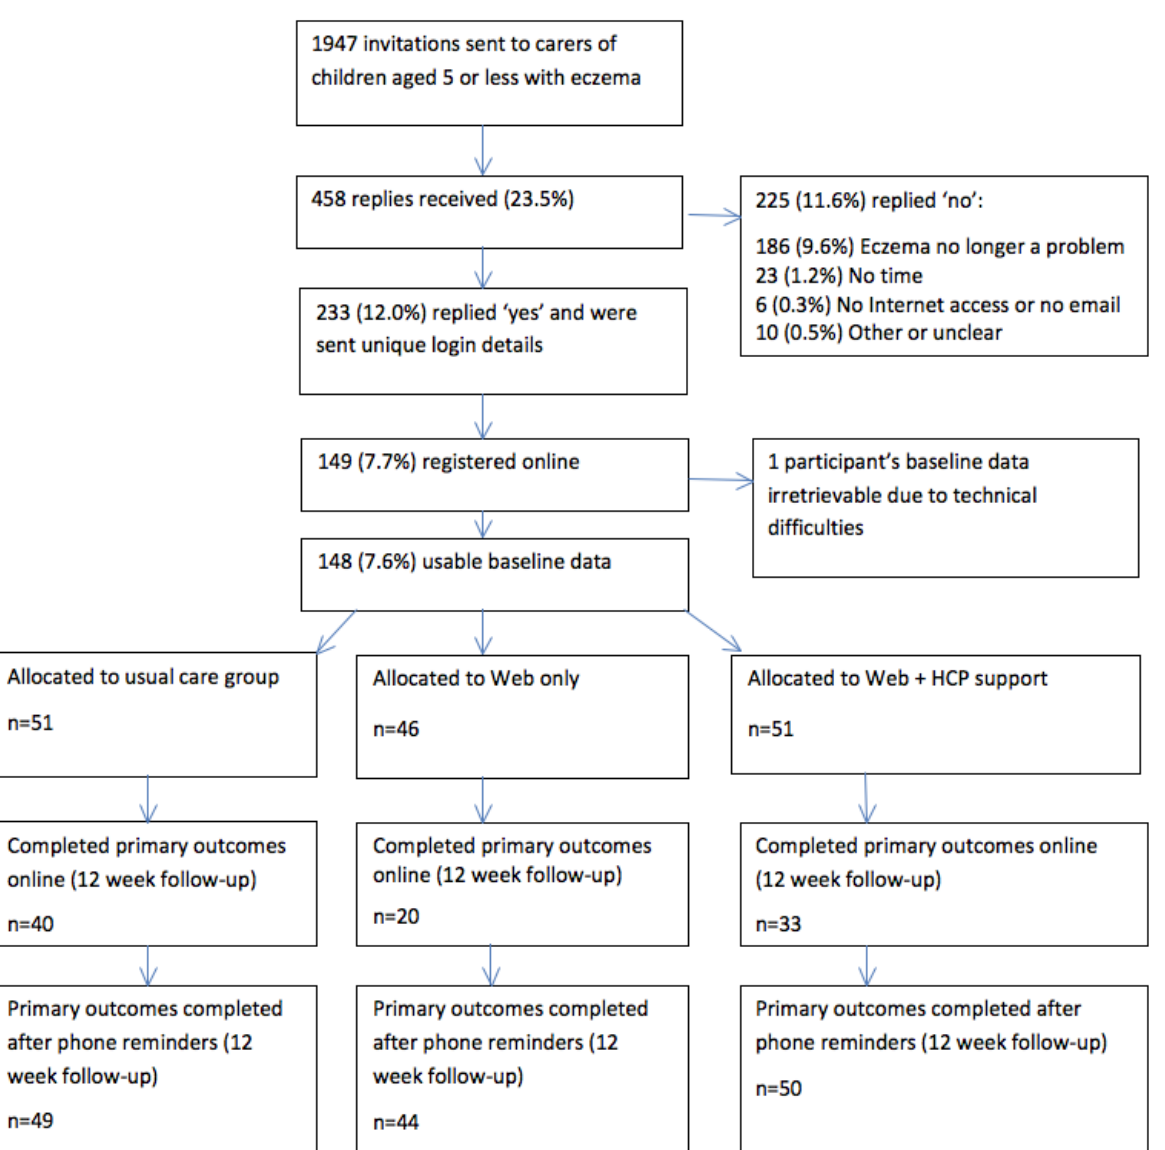
Figure 3. Flow of study participants through